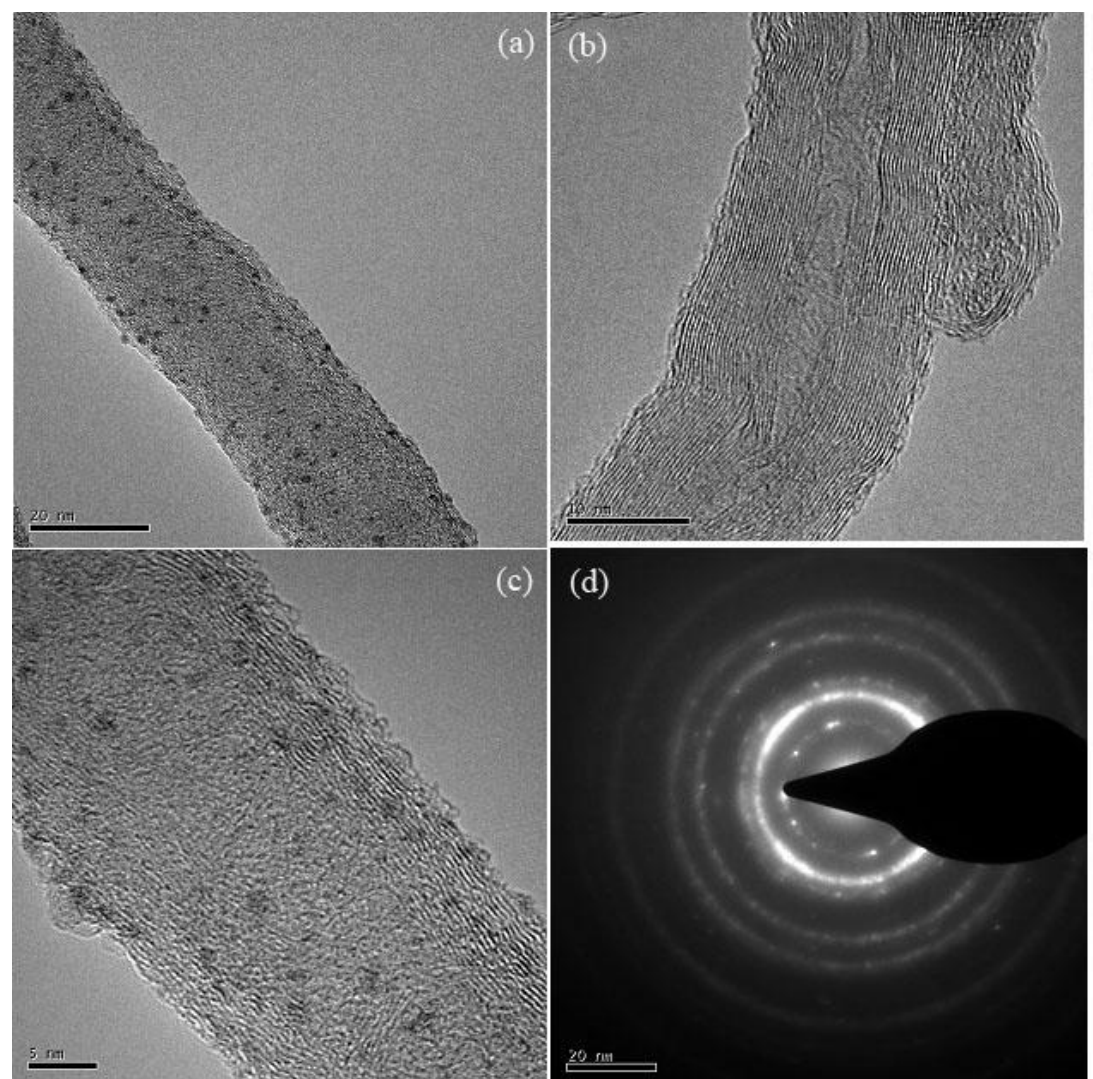
Figure 1. ( a ) TEM images of Pt NPs deposited on MWCNTs; ( b ) MWCNTs without Pt NPs; ( c ) a magnified image for Pt NPs deposited onto the MWCNTs surfaces; ( d ) the selected area electron diffraction (SAED) image of the